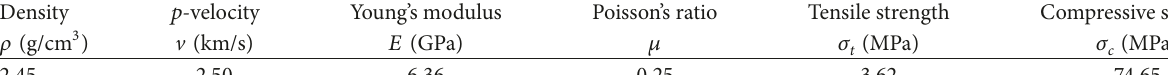
Table 1: Physical and strength properties of coal measure sandstone.